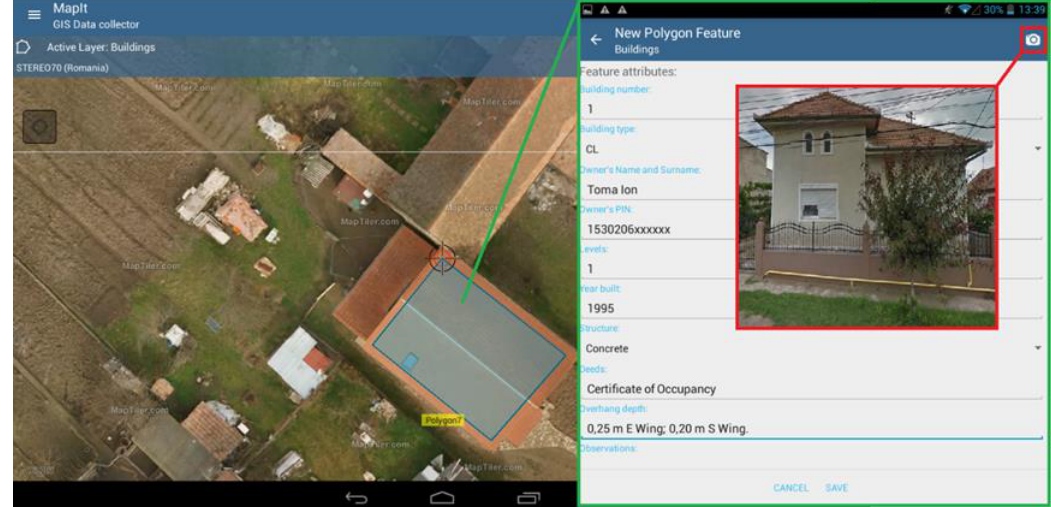
Figure 12. Map IT’s interface for property boundaries data collection – uploading a photo of the property.